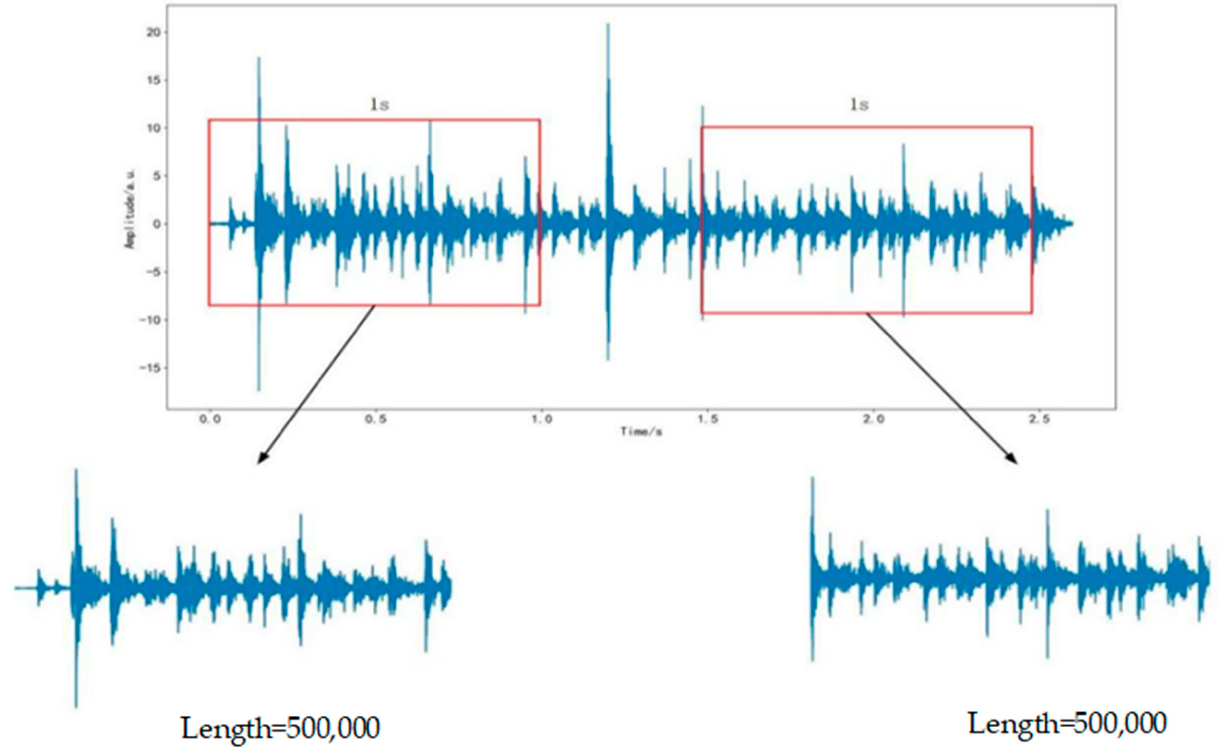
Figure 3. Segmentation of six signal types.